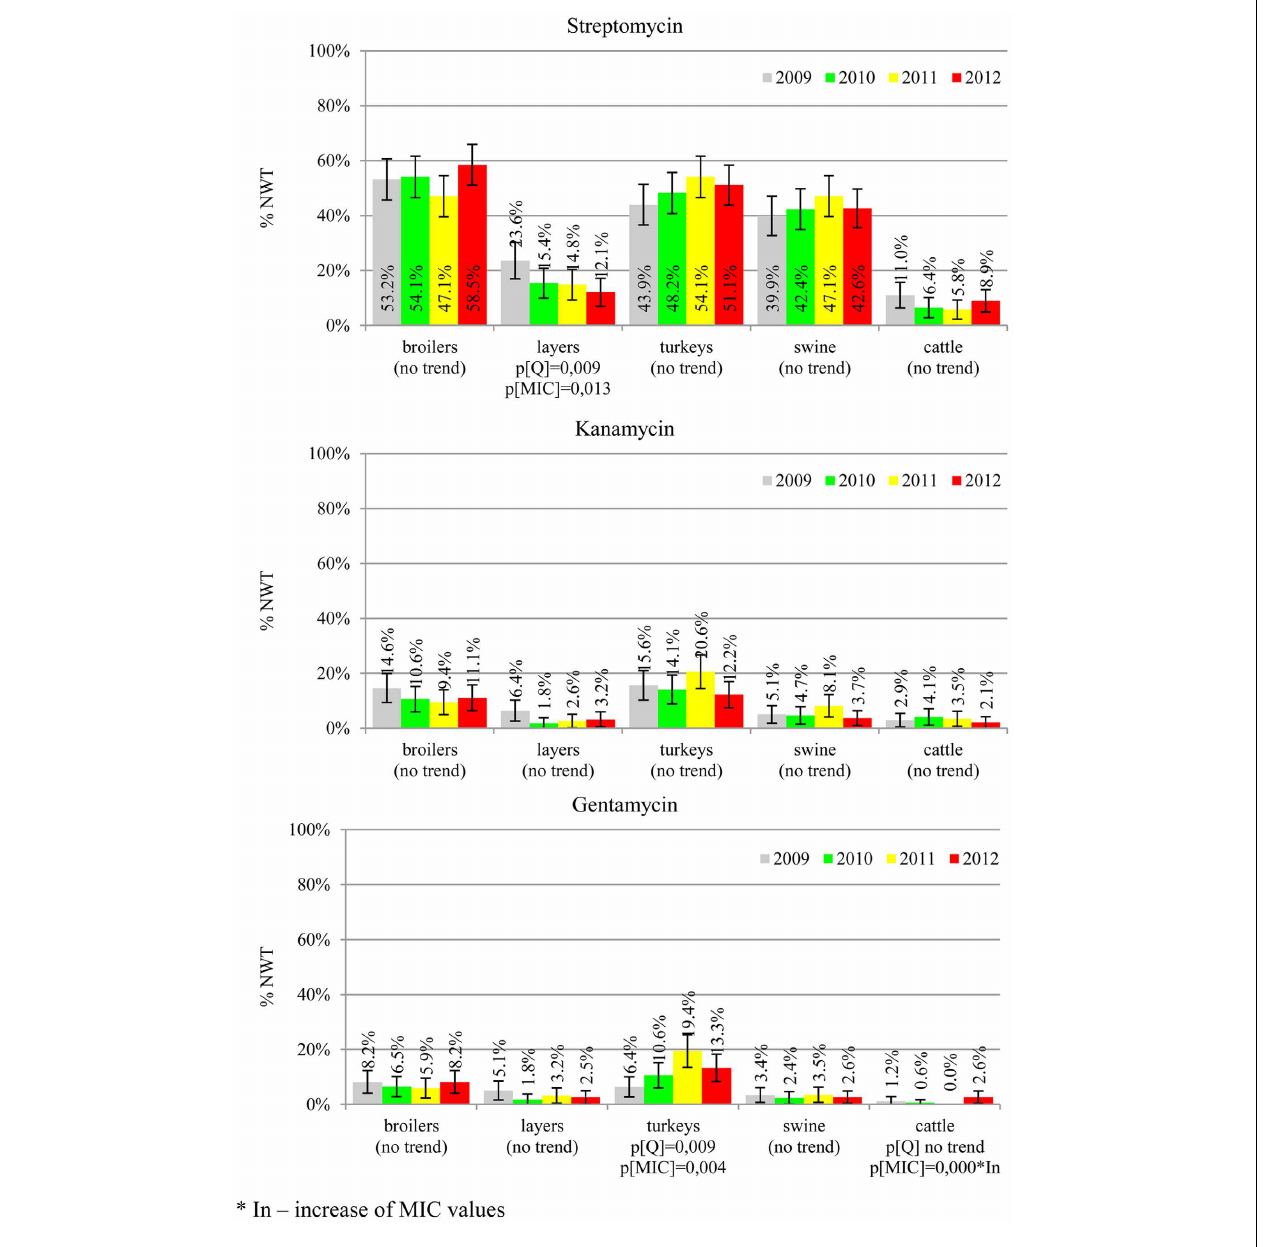
FIGURE 4 | Microbiological resistance to